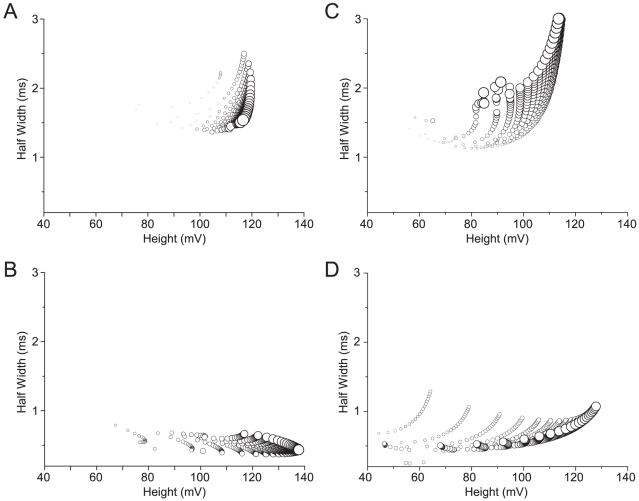
The relationship between action potential height, width and energy consumption within a neuron model.(A) The relationship between action potential height, width and Na+ load when the conductances of the Na+ and K+ voltage-gated channels are scaled in the squid giant axon (SA) model. In all the panels the size of the circle is proportional to the Na+ load of a single AP, larger circles indicating higher action potential Na+ load. (B) The relationship between action potential height, width and Na+ load when the time constants (τh, τn) of the Na+ and K+ voltage-gated channels are scaled in the squid giant axon (SA) model. (C) The relationship between action potential height, width and Na+ load when the conductances of the Na+ and K+ voltage-gated channels are scaled in the rat hippocampal interneuron (RHI) model. (D) The relationship between action potential height, width and Na+ load when the time constants (τh, τn) of the Na+ and K+ voltage-gated channels are scaled in the rat hippocampal interneuron (RHI) model.